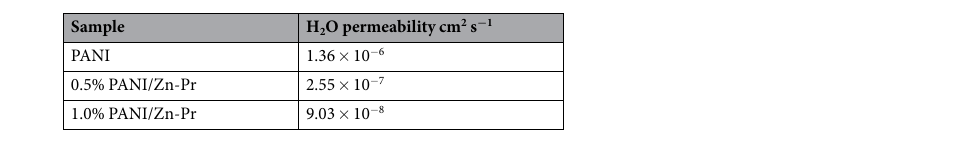
Table 2. Water permeability of PANI coating in the absence and presence of Zn-Pr at 298